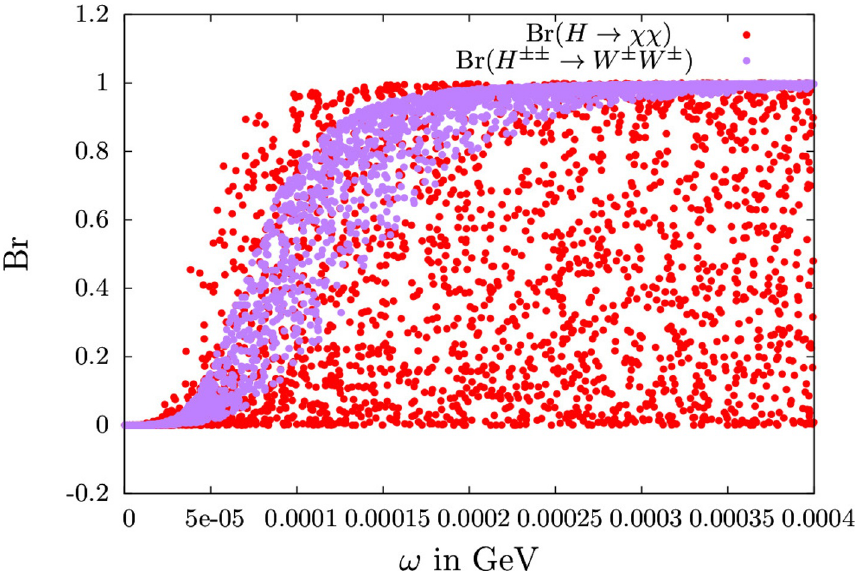
Figure 8 . Distribution of various branching ratios as a function of triplet VEV.